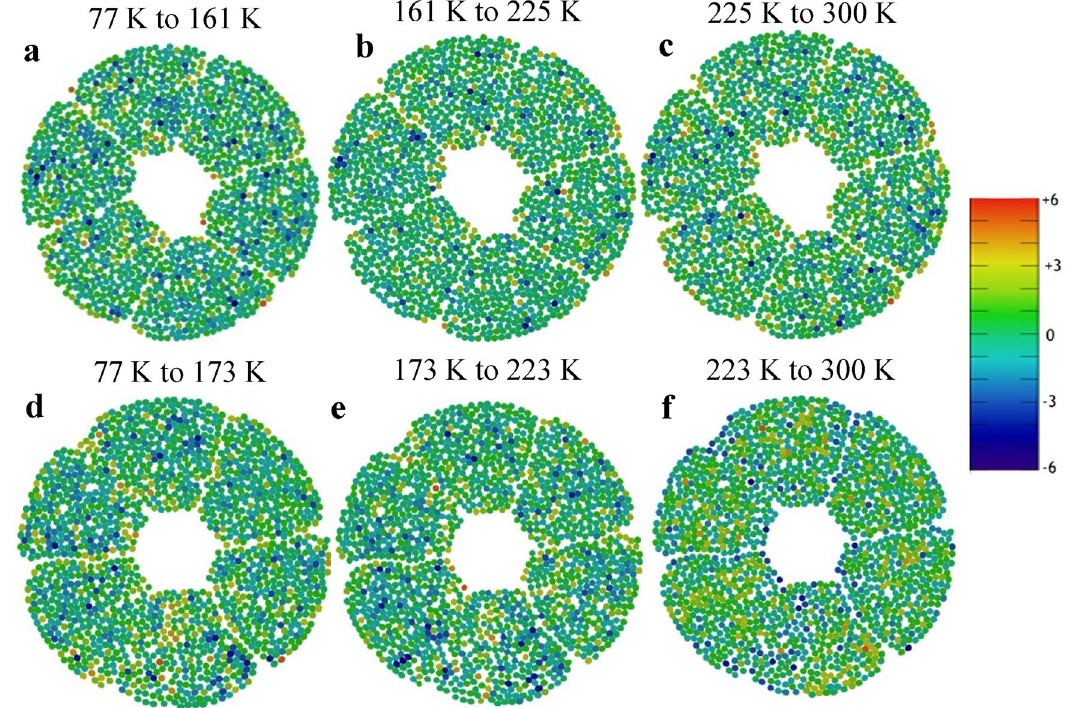
Figure 6. Touch number variation as a function of temperature. ( a – c ) Relative difference in touch number value for each superconducting bundle of the heat-treated section of conductor. A unitless colour scale is used to map and quantify the degree of change between each step in temperature. ( d – f ) Equivalent colour maps for the same section of a non-heat-treated